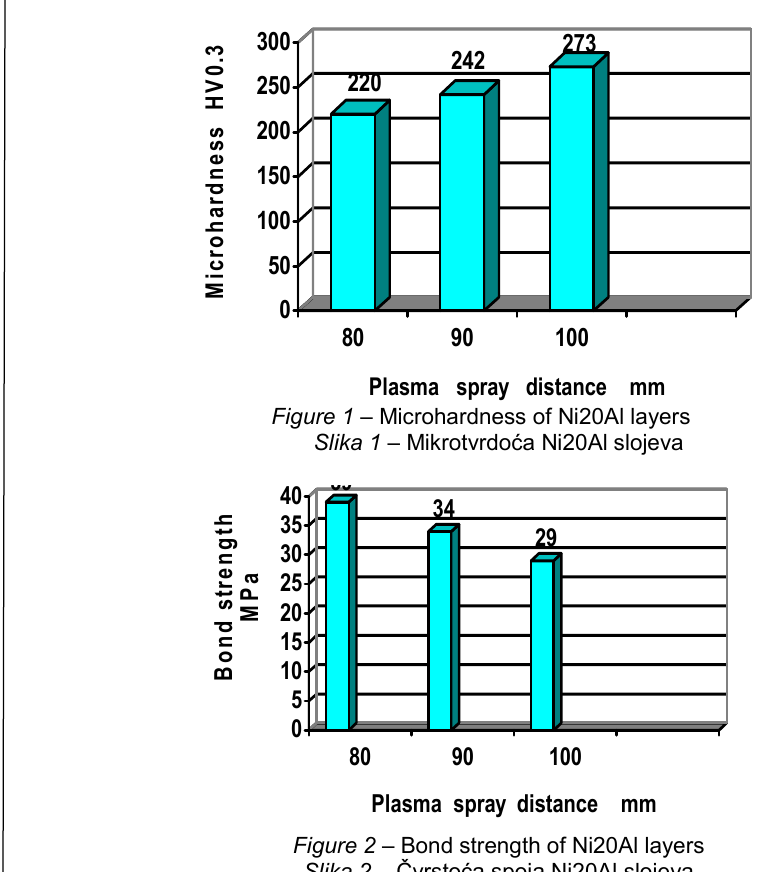
Figure 2 – Bond strength of Ni20Al layers Slika 2 – Č vrsto ć a spoja Ni20Al